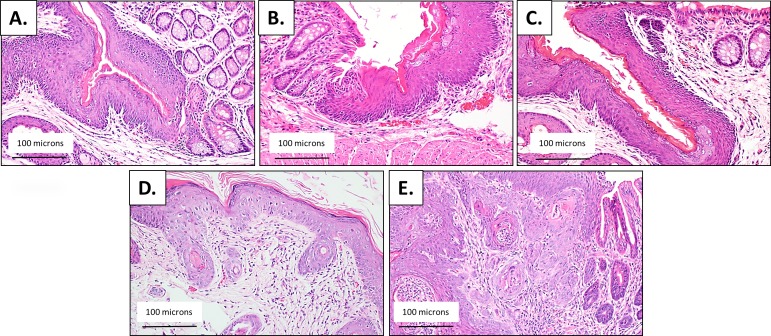
Histological examination of anal transition zone (ATZ) of K14E6/E7 double transgenic mice throughout a time course of no treatment versus DMBA treatment.(A) H&E staining of animals not treated with DMBA at the 5 week timepoint reveals normal epithelium. (B) Following 5 weeks of DMBA treatment, there is inflammation on H&E staining. (C) At 10 weeks of DMBA treatment there is histological evidence of low-grade dysplasia. (D) High-grade dysplasia is present at 15 weeks of DMBA treatment and (E) invasive squamous cell carcinoma at 20 weeks of DMBA treatment. All images are acquired at 20x magnification.